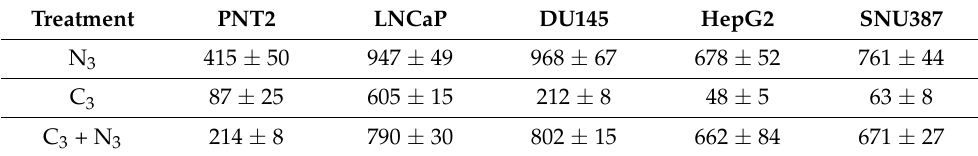
Table 4. Number of internalized nanoparticles per treatment in each type (Mean ± SD).